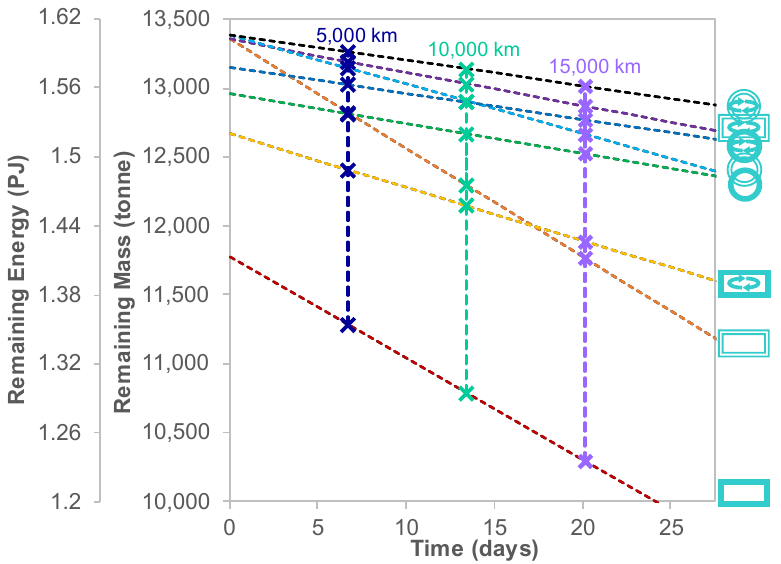
Figure A3. Variation of remaining fuel mass and energy with voyage duration at BN = 2 and a resultant velocity of 16.7 knots. All investigated LH2 fuel cell ships are shown at the insulation thickness that maximises the fuel delivered after a voyage of 20 days.